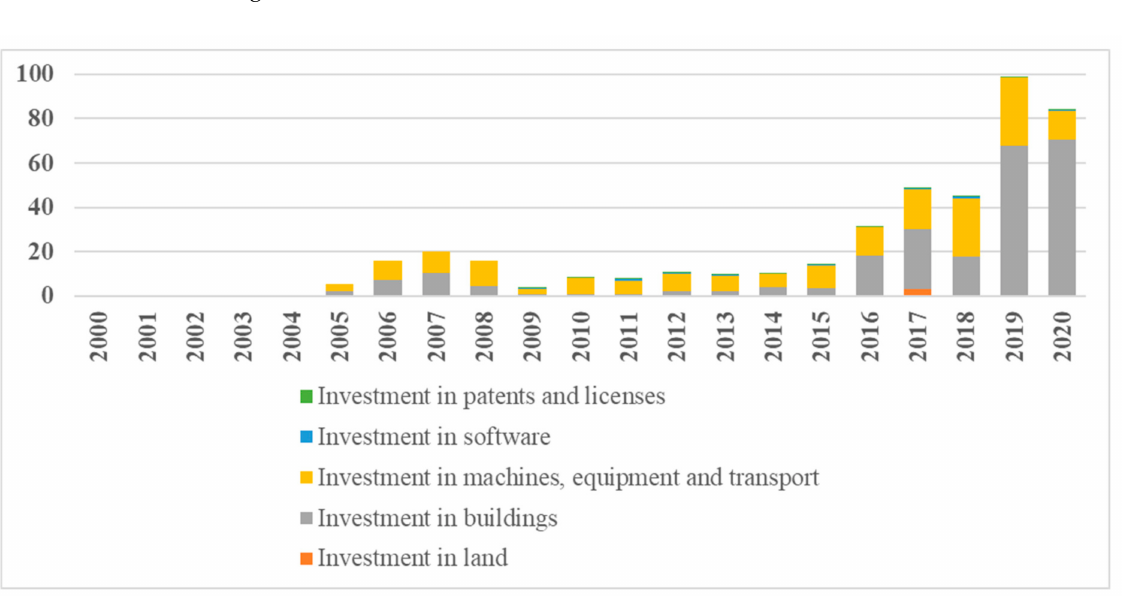
Figure 6. Investment by asset type, million EUR.